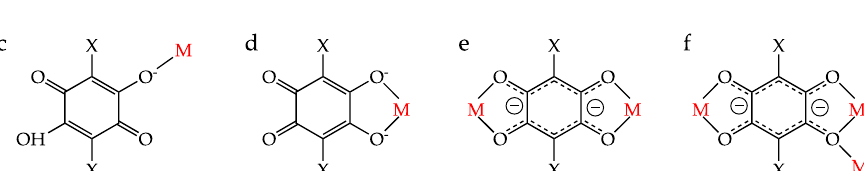
2 C 6 O 4 X 2 ). ( b ) Reduced forms of